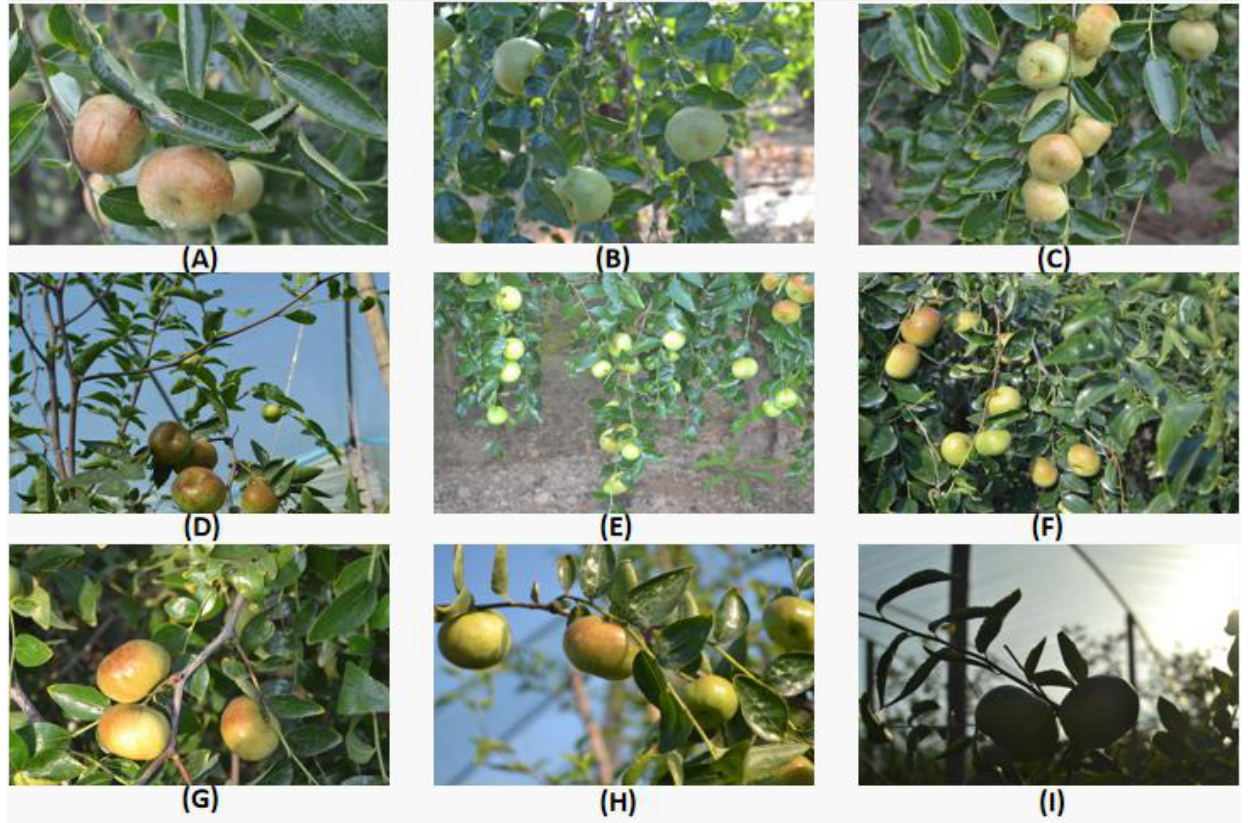
Figure 1. Data samples under different environments. ( A ) occluded by branches ( B ) occluded by leaves ( C ) overlap ( D ) sky background ( E ) soil background ( F ) crown background ( G ) sunlight angle ( H ) sidelight angle ( I ) backlight angle.